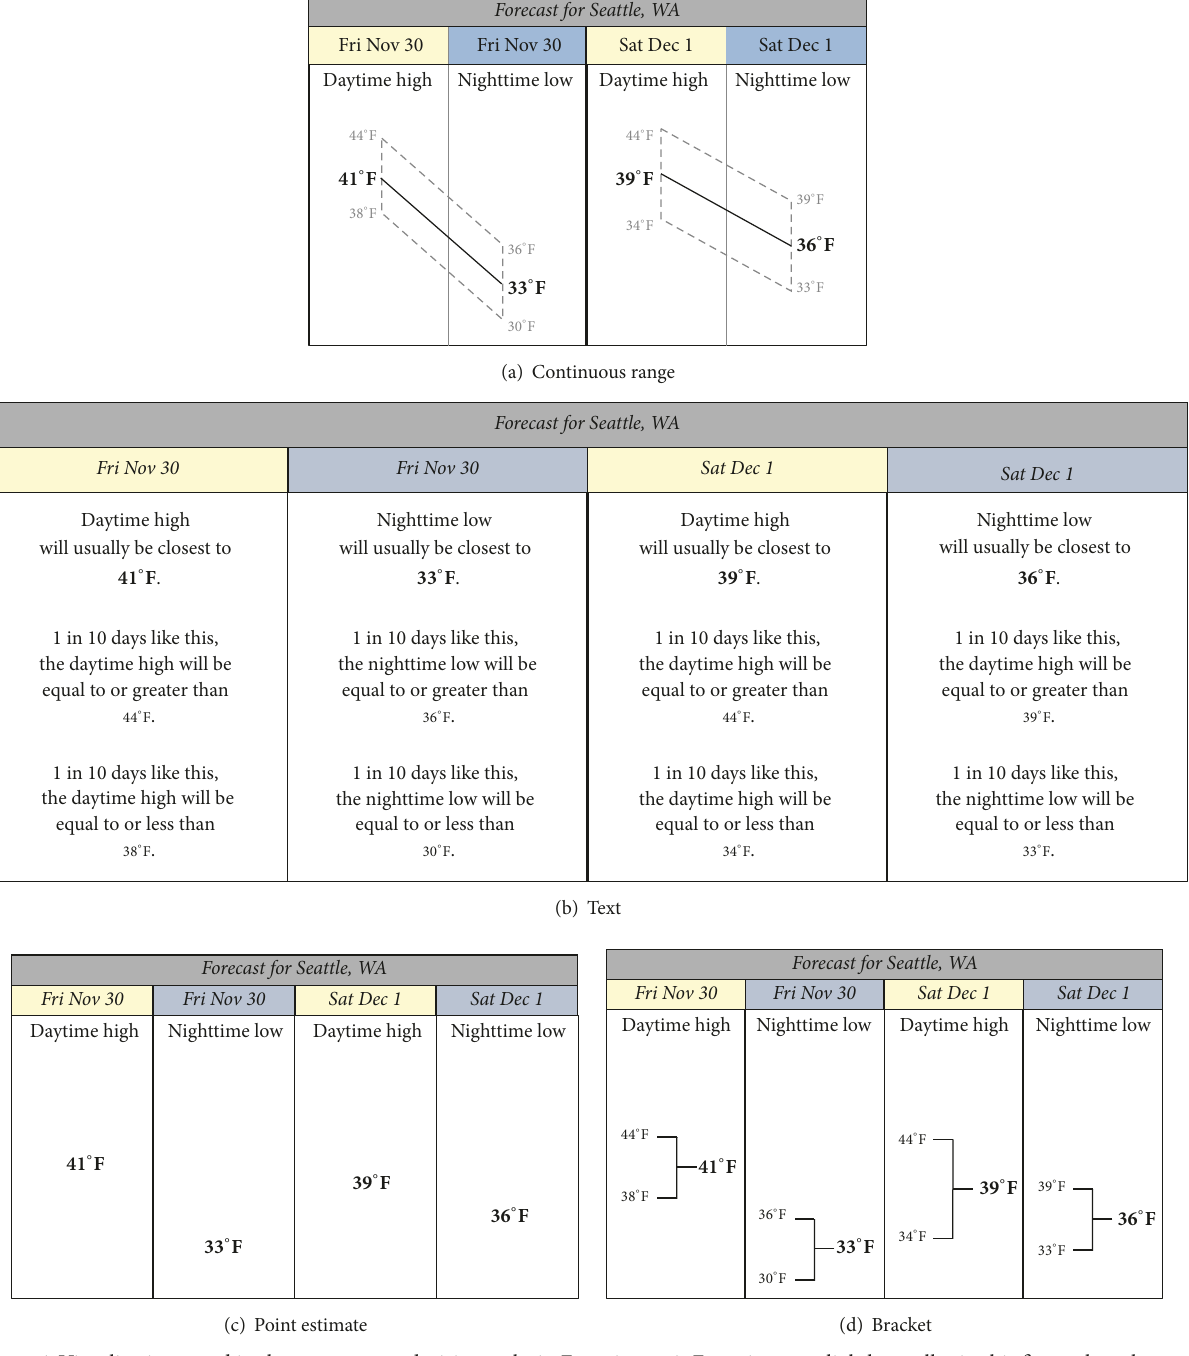
Figure 6: Visualizations used in the temperature decision tasks in Experiment 2. Font sizes are slightly smaller in this figure than they were in the experiment to conform to journal